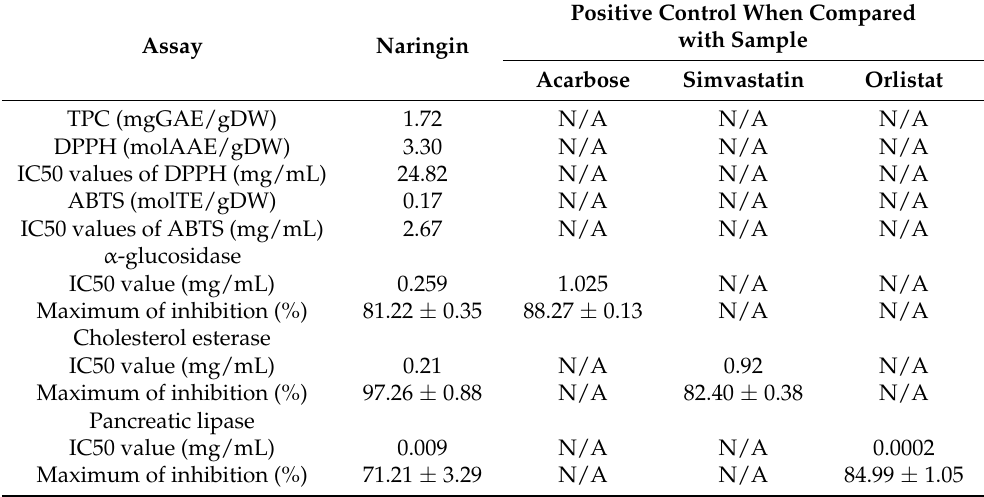
Table 2. IC50 values and % inhibition of antioxidant activity assays and enzymes in the digestive system of naringin. Positive Control When Compared with Sample Assay Naringin Acarbose Simvastatin Orlistat TPC (mgGAE/gDW) 1.72 N/A 3.30 IC50 values of DPPH (mg/mL)